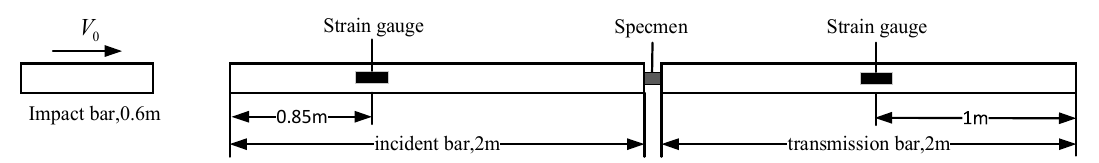
Figure 3. Split Hopkinson Pressure Bar (SHPB) test system with measurements.